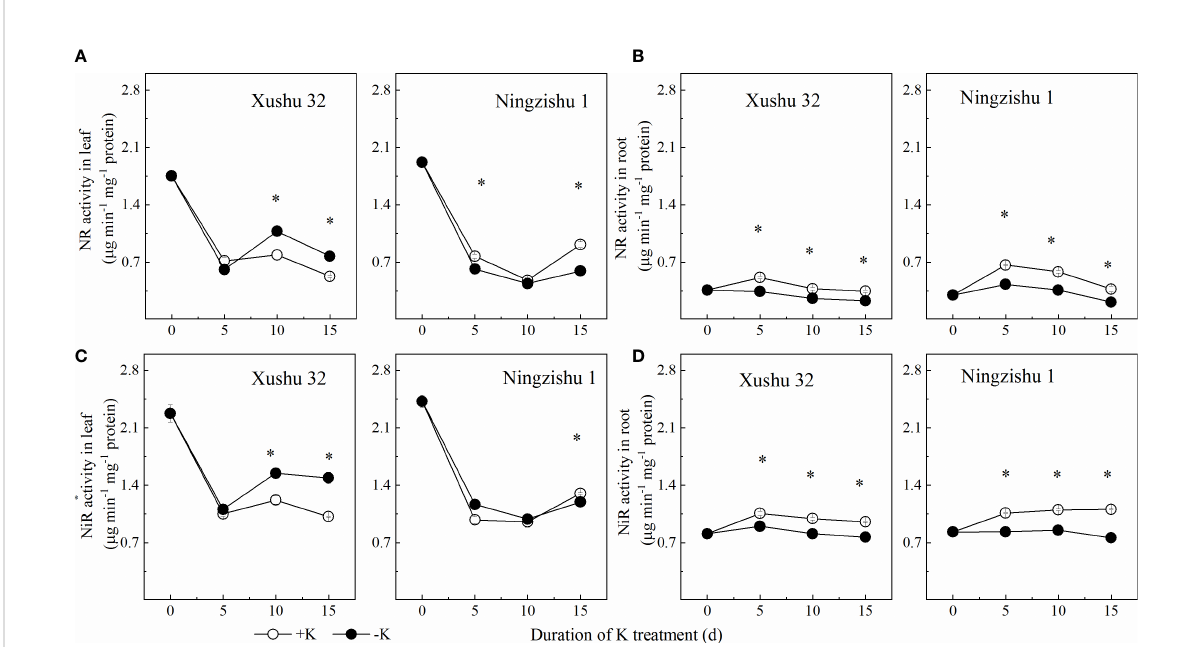
FIGURE 7 Changes of NR and NiR activities in leaves and roots for two K treatments for Xushu 32 and Ningzishu 1. (A, B) leaf and root NR activities. (C, D) Leaf and root NiR activities. The stages labeled with an asterisk (*) indicate signi fi cant differences ( p < 0.05) between − K and +K. NR, nitrate reductase; NiR, nitrite reductase.